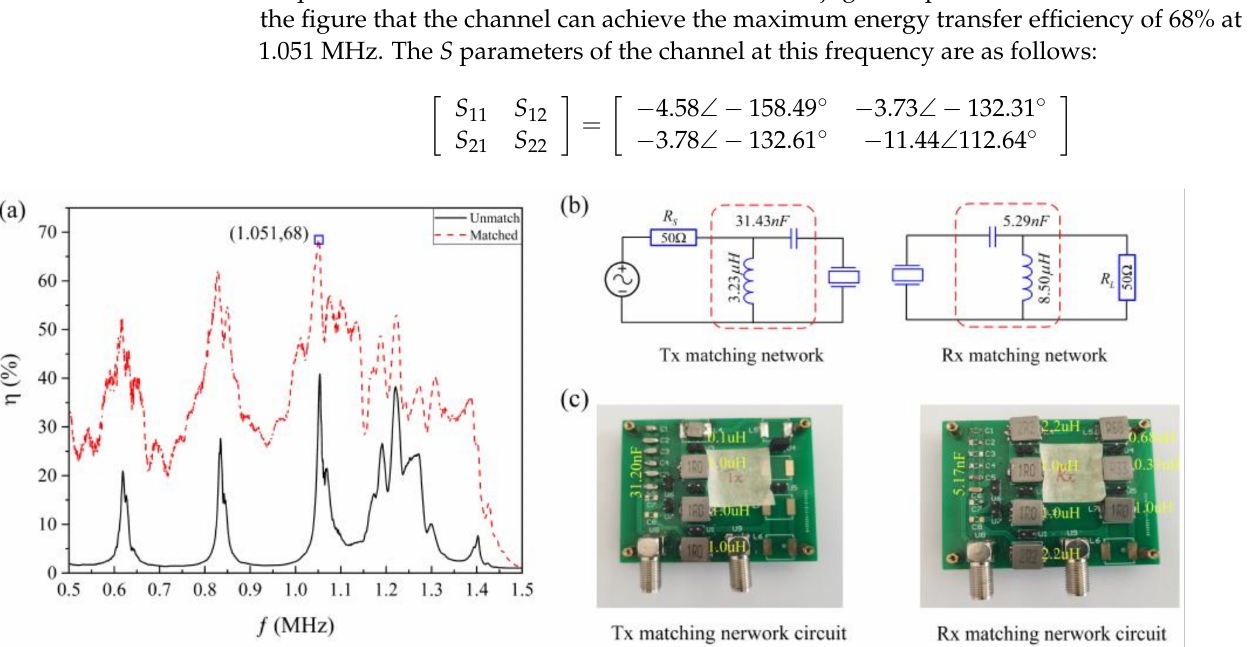
Figure 3. Simultaneous conjugate impedance matching network design. ( a ) Energy transfer efficien- cies of matched and unmatched channels. ( b ) Matching network designed for SCIM. ( c ) Matching network built for